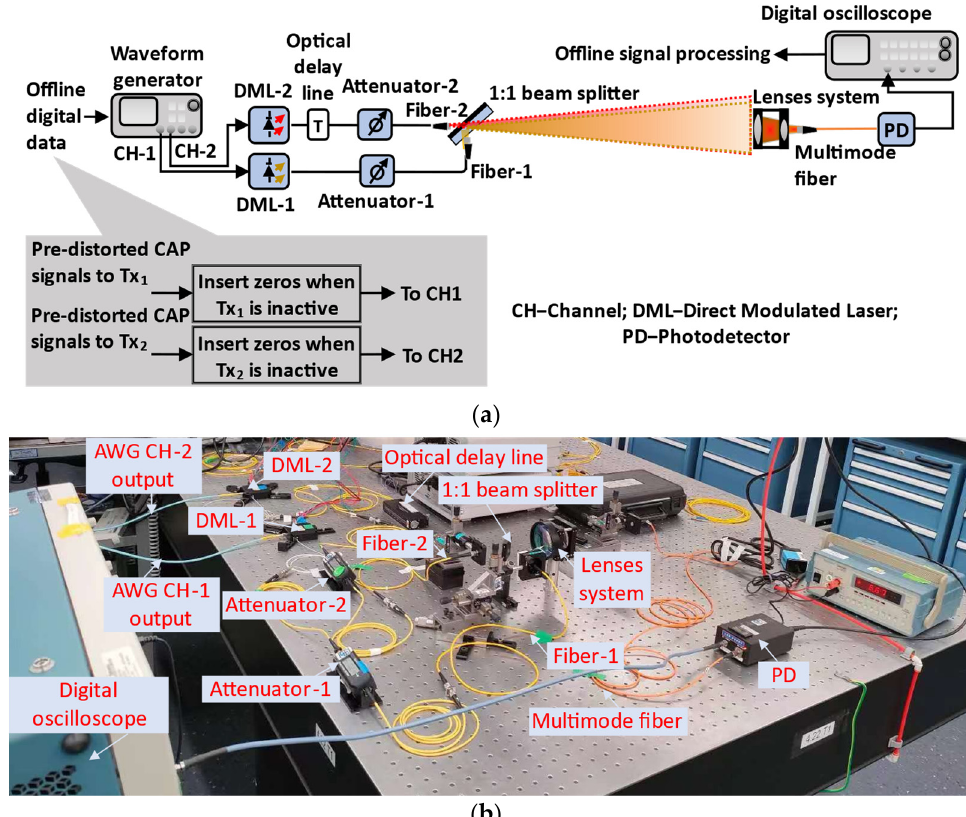
Figure 3. Experimental setup. ( a ) Schematic diagram. ( b ) Photo. Table 1. Physical parameters of the experimental setup.